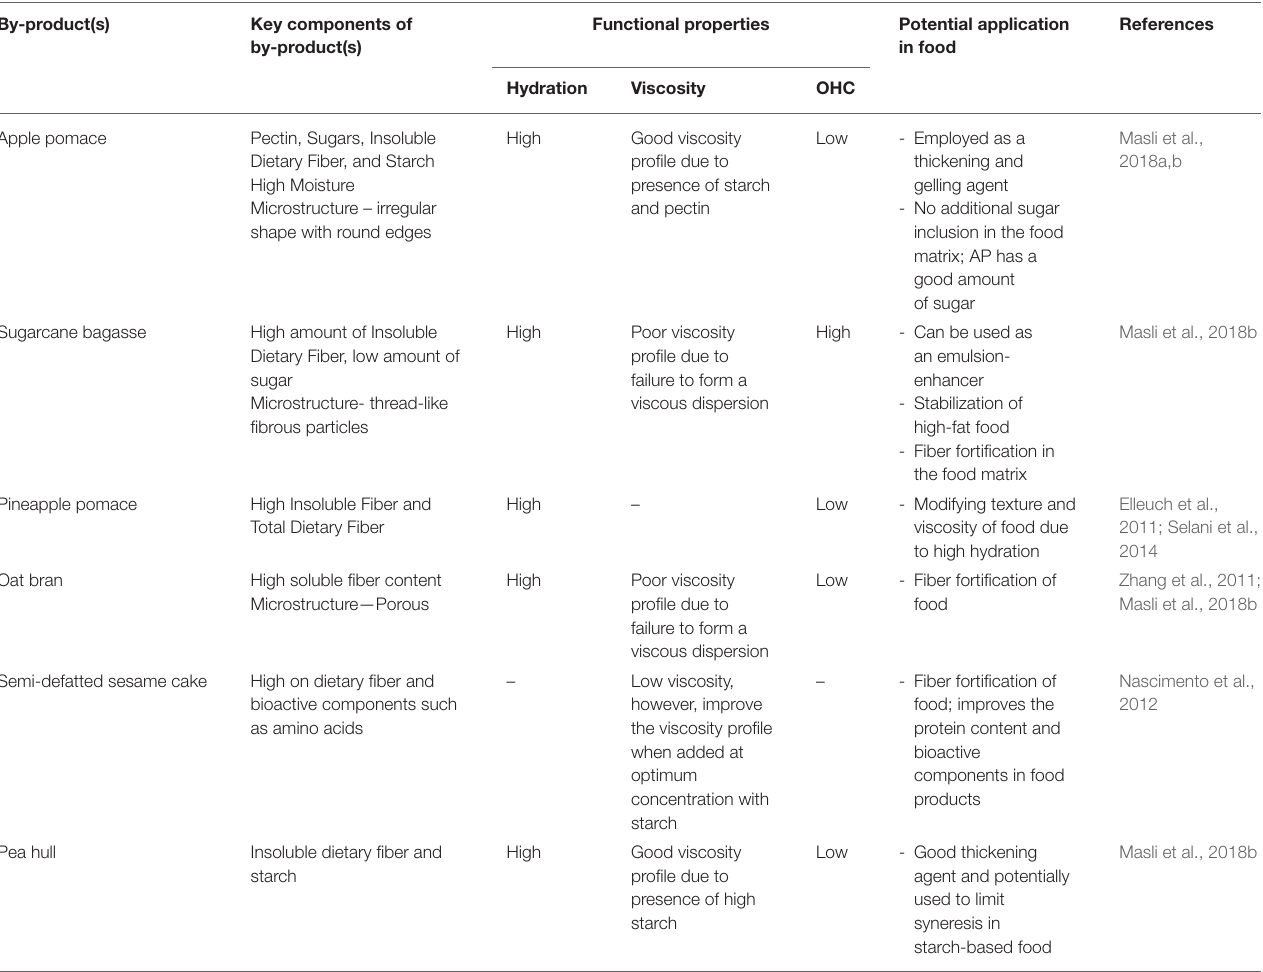
TABLE 2 | Functional properties and potential applications of selected by-products in food processing. By-product(s) Key components of